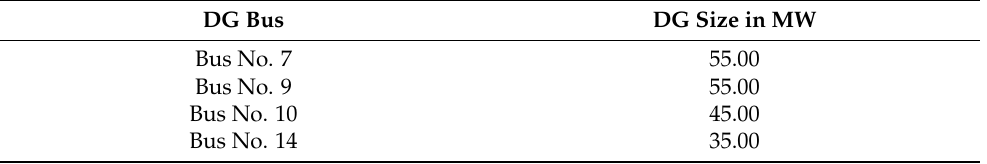
Table 5. Optimal bus and DG size for the 14-bus system of